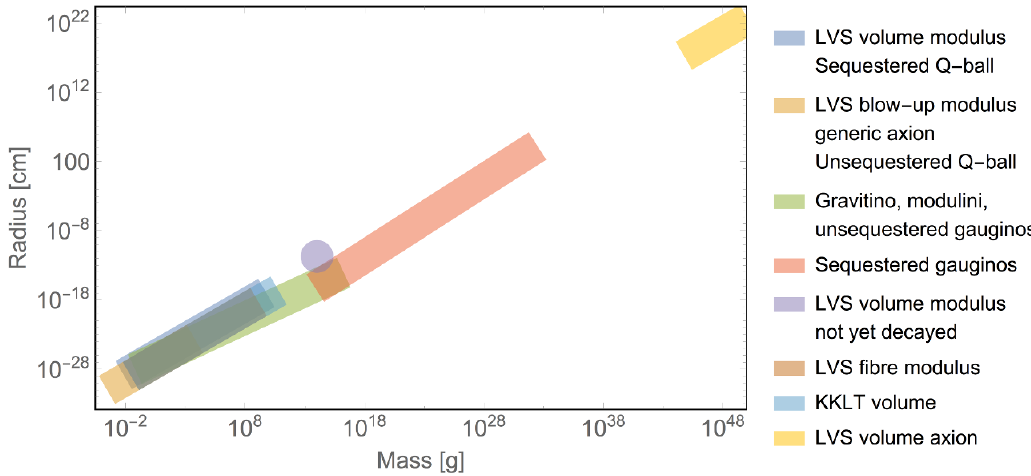
Figure 9 . Summary of expected mass ranges and radii for typically considered values of the overall volume and (cid:13)ux